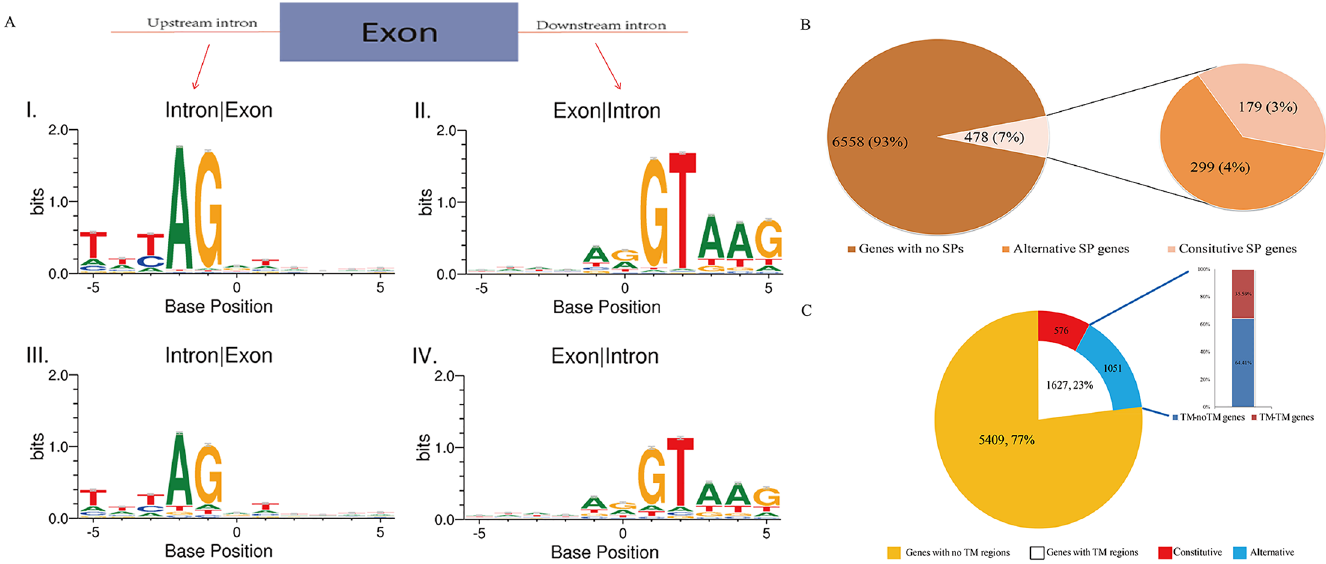
Fig 4. Binding motif search and alternative splicing in excretory and secretory proteins encoding genes. A, Sequence situations in boundaries of Cassette exons and alternative exons. Four bases frequencies in both ends of an exon and flank introns in five positions were calculated and showed by Weblogo 3.3 (http://weblogo.threeplusone.com/). I, left boundaries of cassette exons, namely intron-exon boundaries. II, right boundaries of cassette exons, namely exon-intron boundaries. III, left boundaries of alternative exons. IV, right boundaries of cassette exons. B, Alternative splicing in genes encoding proteins with signal peptides (SPs). Signal peptides were predicted using online tool SignalP 4.1 server, setting as default (D-cutoff for SignalP-noTM networks is 0.45 and D-cutoff for SignalP-TM networks is 0.5). Numbers in the pie chart imply gene amounts and percentages. Genes with no SPs: genes predicted as encoding transcripts with no signal peptides. Alternative SP genes: genes predicted as encoding multiple transcripts with or without signal peptides. Constitutive SP genes: genes predicted as encoding multiple transcripts with signal peptides. C, Alternative splicing in genes encoding proteins with transmembrane (TM) domains. Transmembrane domains were predicted using online tool TMHMM server2.0, setting as default. Annotations in the pie chart indicate gene amount and percentage. Constitutive: genes encode transcripts possessing transmembrane domains without alternative splicing found. Alternative: genes encode transcripts possessing transmembrane domains with alternative splicing found; TM- noTM genes: genes encode multiple transcripts with and without TM domains; TM-TM genes: genes encode multiple transcripts possessing different amount of TM domains.